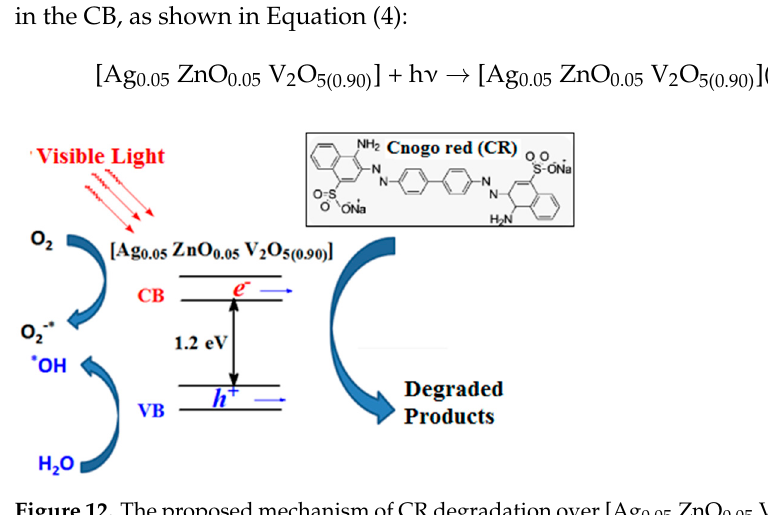
Figure 12. The proposed mechanism of CR degradation over [Ag 0.05 ZnO 0.05 V 2 O 5(0.90) ] photocatalyst under visible-light irradiation.